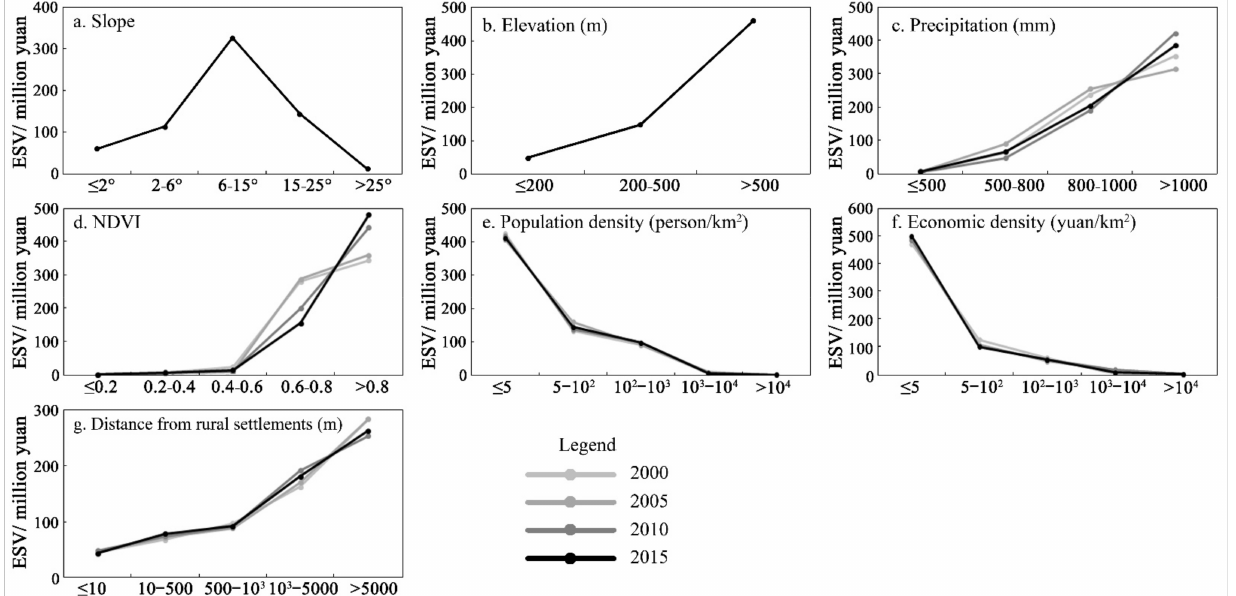
Figure 4. ESV distribution under different gradients of influencing factors in the Funiu Mountain area.